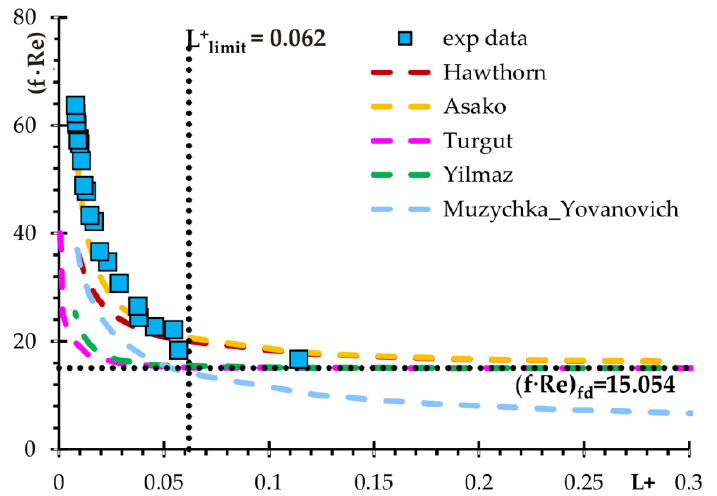
Figure 1. Comparison of experimental results with literature solutions for tested structure.